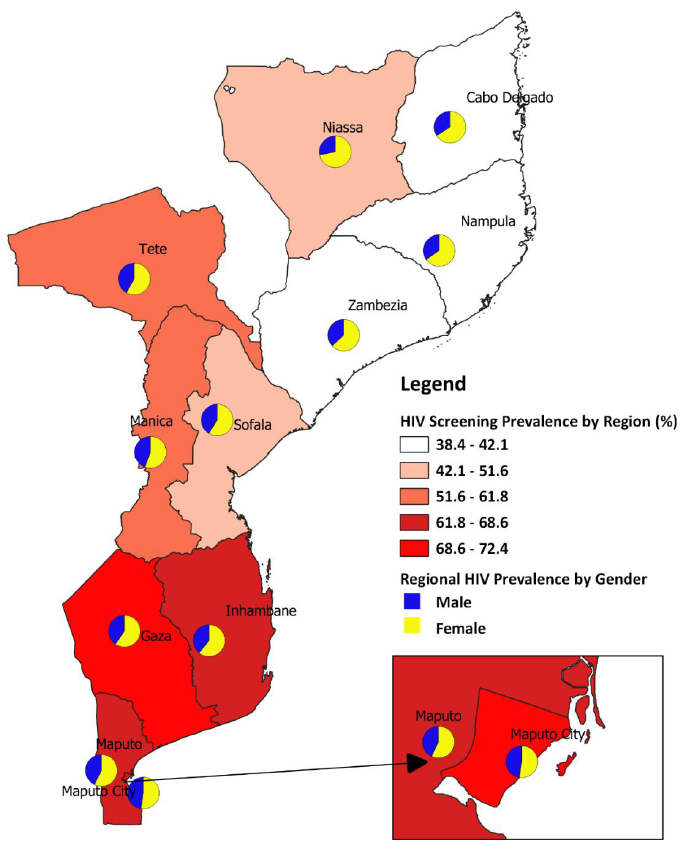
Figure 1. Provincial HIV screening prevalence by gender.